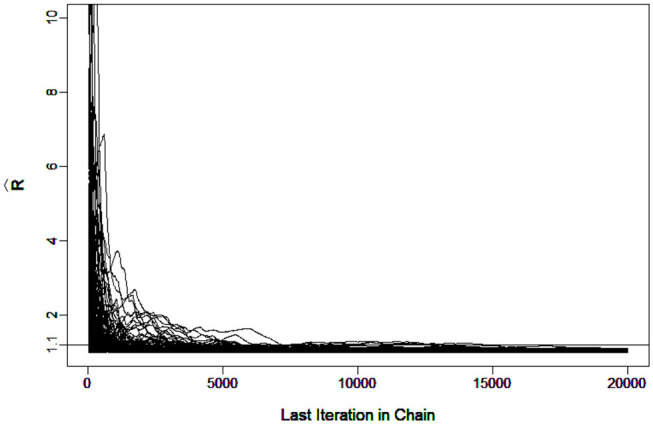
Trace Plots of R^ under G-DINA model for I = 1, 000.